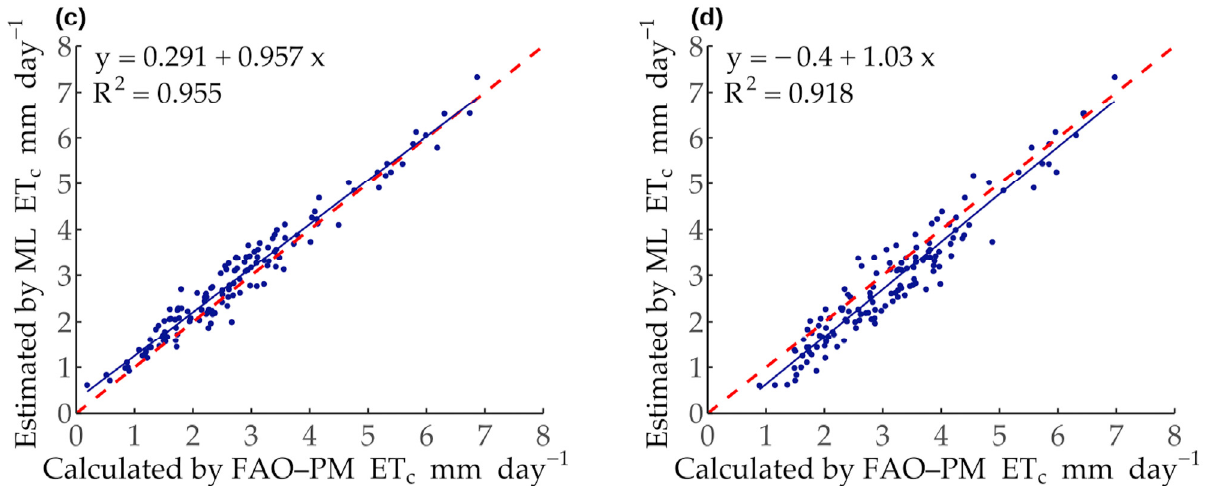
Figure 5. Scatter plots of calculated daily spring maize ET c values by FAO–PM method compared with ML model-estimated values with K c , T ave , T max , T min , n and RH as the input. RF–SVR–PSO model